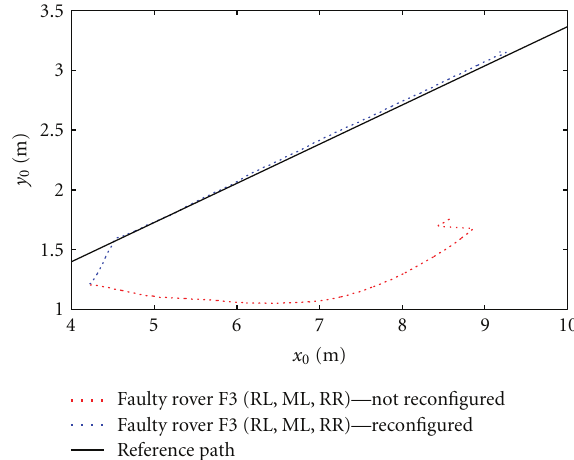
Figure 19: Fault-tolerant control performance for ExoMars Rover under fault F2.